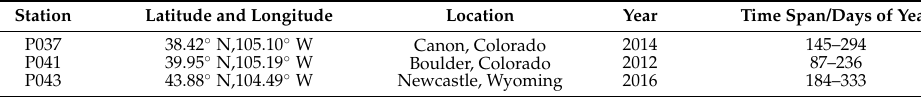
Figure 4. ( a ) The distribution and surrounding environment of P037, P041, P043 stations; ( b ) the soil moisture-rainfall diagram during the experimental period. Table 1. Stations data usage. Table 1. Stations data